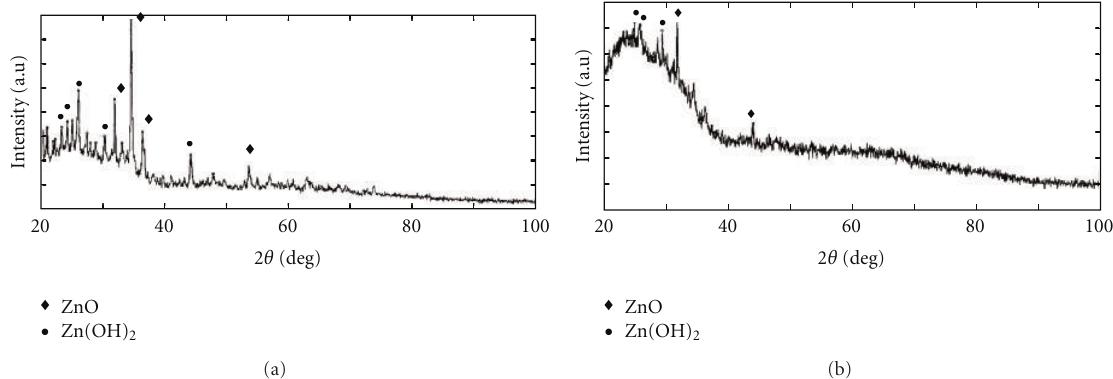
Figure 1: X-ray di ff ractograms of (a) as-deposited ZnO coating and (b) ZnO coating heat treated at 70 ◦ C and immersed in stearic acid (0.002M).